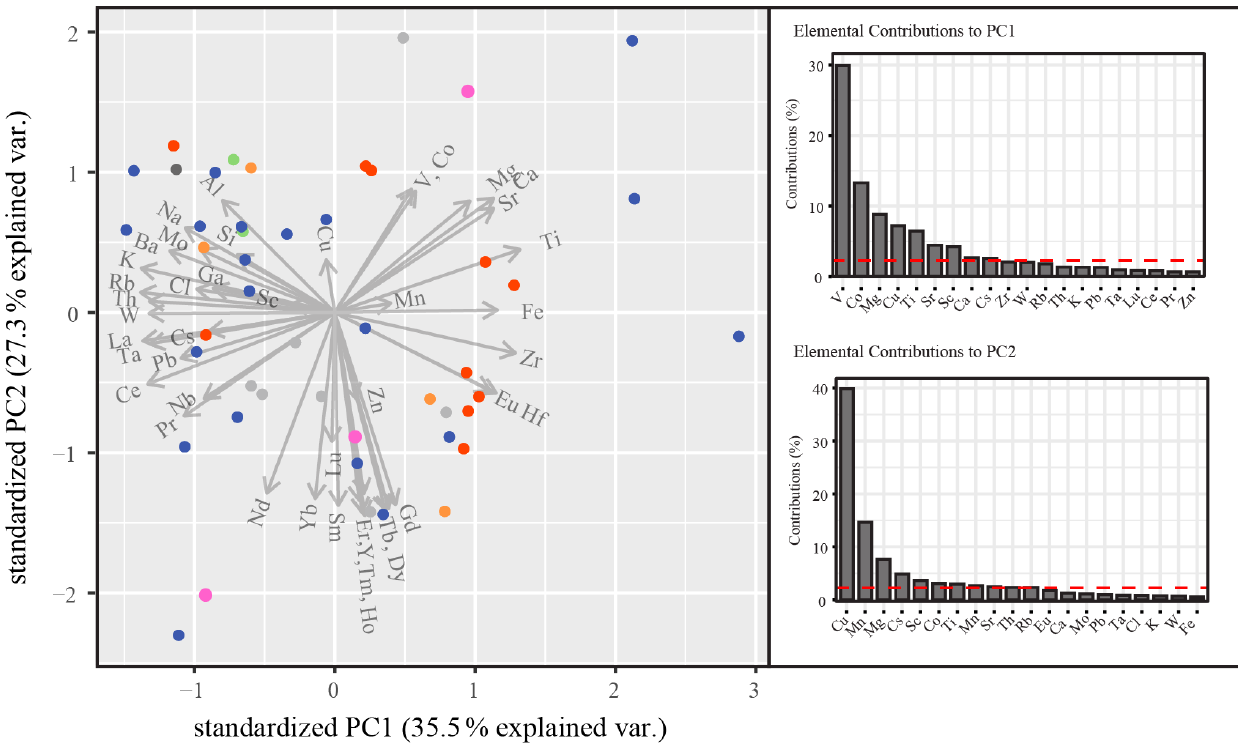
Figure 10. Results of PCA on all TephraNZ reference data for glass. Data are scaled to allow comparison within the PCA analysis. Tephra samples are coloured as per their source centre (see key in Fig. 9). Mean ellipses have been removed for clarity for this figure. PCA analysis was performed in R (see Supplement 1 for R script). Bar plots highlight the top elemental contributions for PC1 and PC2. The red dashed line on the elemental contribution plots indicates the expected average contribution; a variable with a contribution larger than this cut-off line is considered important in contributing to the